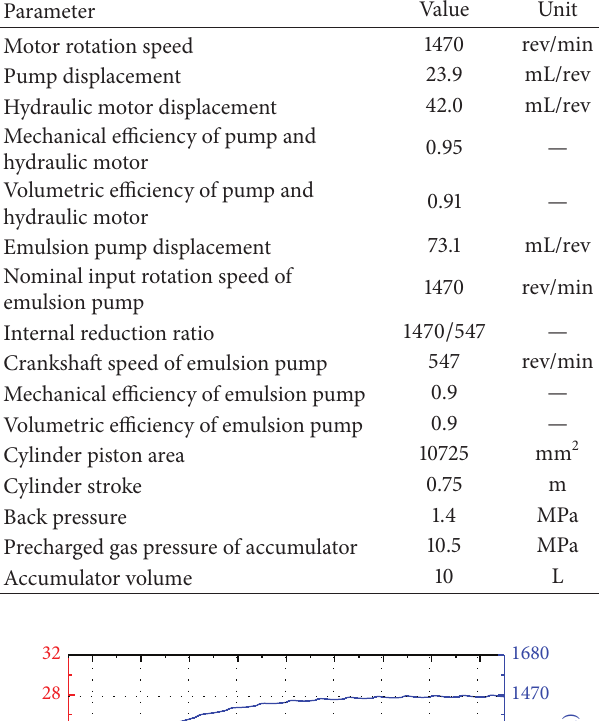
Table 1: Simulation parameters.